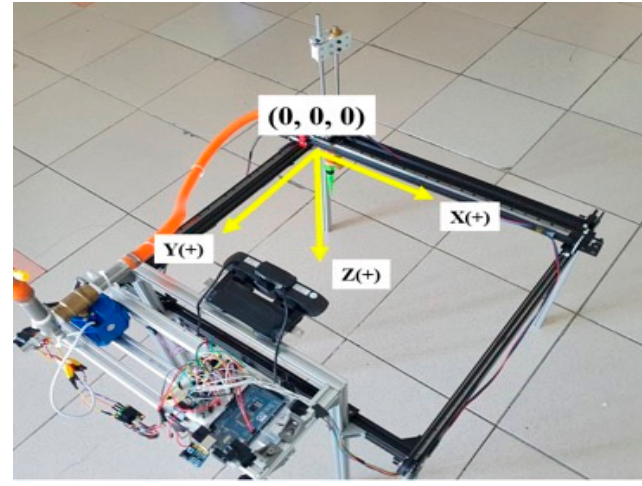
Figure 18. The coordinate system of the three-axis motion platform.